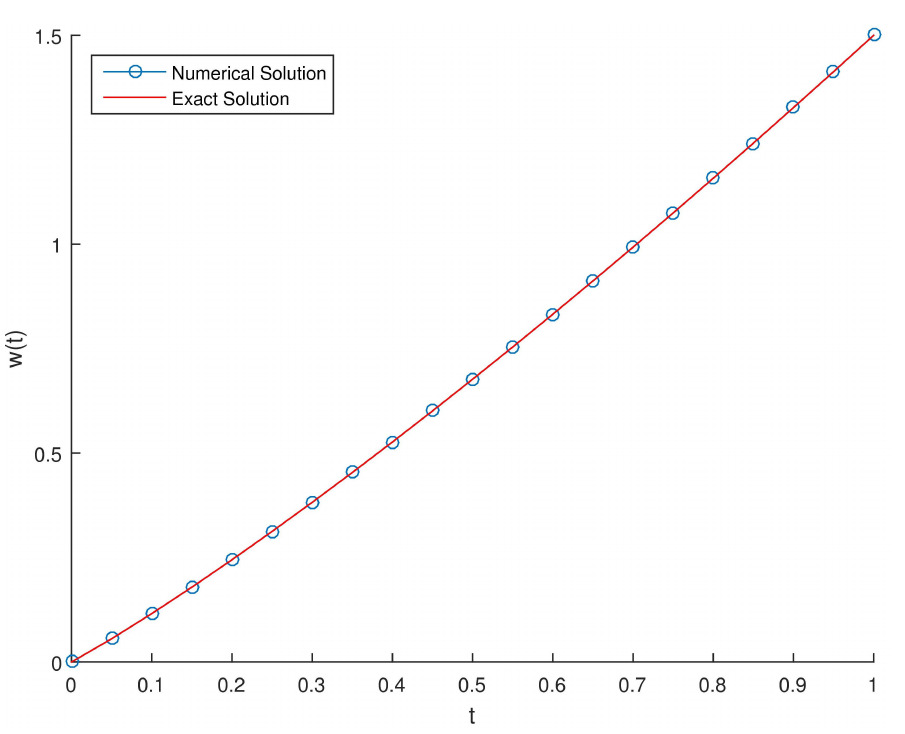
Figure 11. The compared results of the approximate and exact solutions for Example